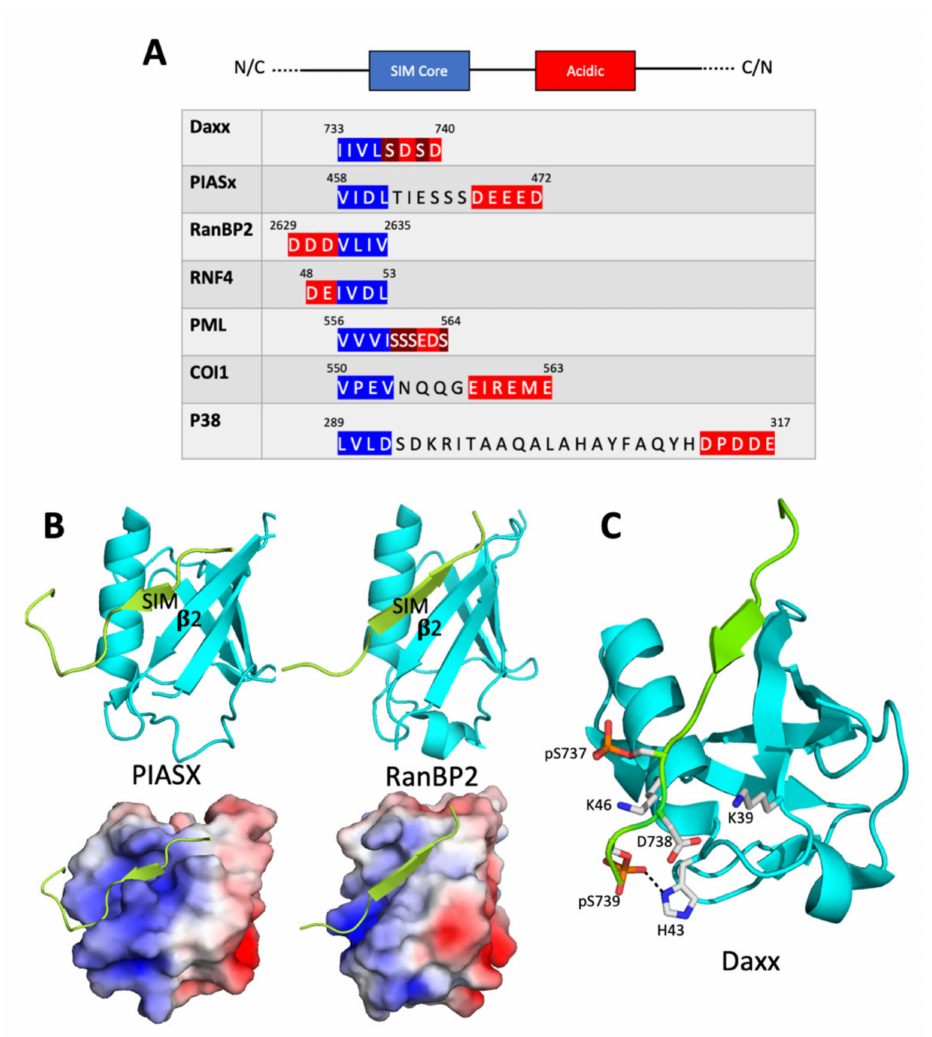
Figure 1. SIM consensus and the structure of the SUMO/SIM complex. ( A ) The consensus SIM structure which includes a SIM hydrophobic core flanked by negatively charged residues is shown at the top. The consensus can run in either direction (N-terminal to C-terminal or C-terminal to N- terminal). Below the consensus structure are portions of sequences from a few of the SIM-containing proteins discussed in the text. The SIM hydrophobic cores (blue) and negatively charged regions (red) are highlighted. Two serine residues in Daxx and four serine residues in PML that are phosphorylated to increase the affinity of the SIM for SUMO are highlighted in brown [17]. ( B ) The structures of the PIASX SIM bound to human SUMO-1 (left, PDB ID 2ASQ) and the RanBP2 SIM bound to human SUMO-2 (right, PDB ID 3UIN). In the cartoon representations at the top, the SIMs are green and the SUMOs are cyan. The second β strand in each SUMO is labeled. In the bottom images, the SUMOs are represented as electrostatic surfaces, with blue indicating positive charge and red indicating negative charge. In the PIASX complex, the SIM is parallel to the second β strand, while in the RanBP2 complex, the SIM is antiparallel to the second β strand. ( C ) The structure of the phosphorylated Daxx SIM bound to SUMO-1 (PDB ID 4WJP). In these cartoon representations, SUMO-1 is shown in cyan and the Daxx SIM is shown in green. Side chains of three negatively charged Daxx SIM residues (phospho-Ser737, Asp738, and phospho-Ser739) and three positively charged SUMO-1 residues (Lys39, His43, Lys 46) are shown. A dashed line indicates a close contact between phospho-Ser739 and His43. The electrostatic attractions between the positively charged SUMO residues and the negatively charged SIM residues serve to direct binding of the SIM in the parallel